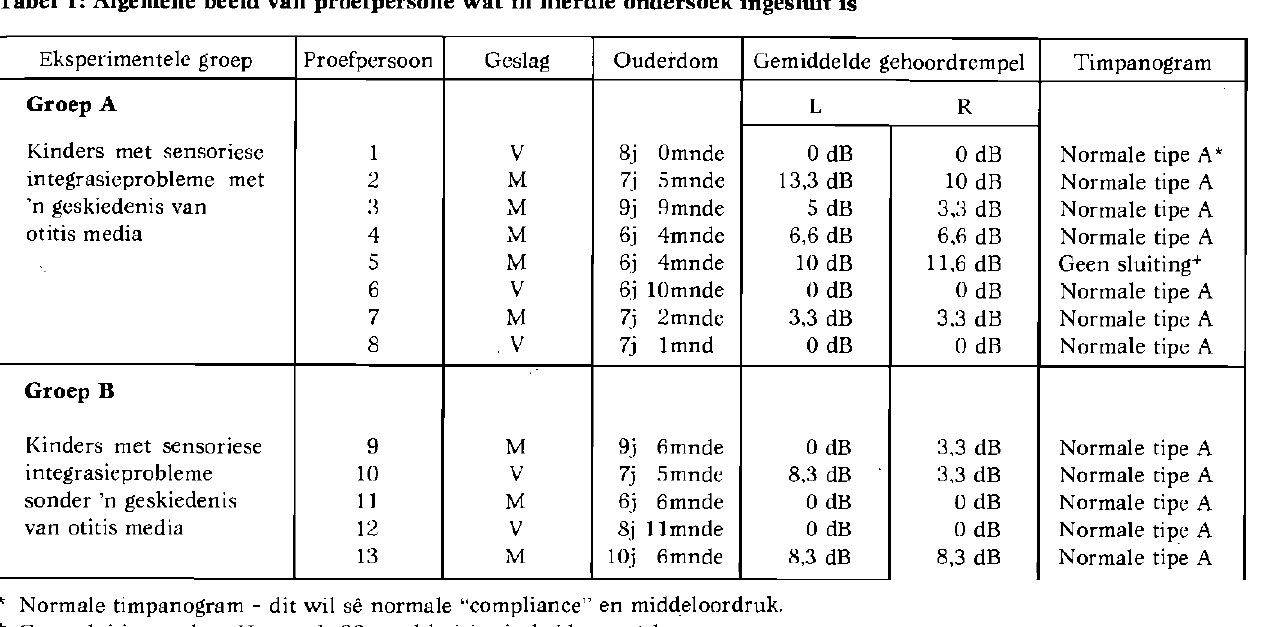
Tabel 1: Algemene beeld van proefpersone wat in hierdie ondersoek ingesluit is